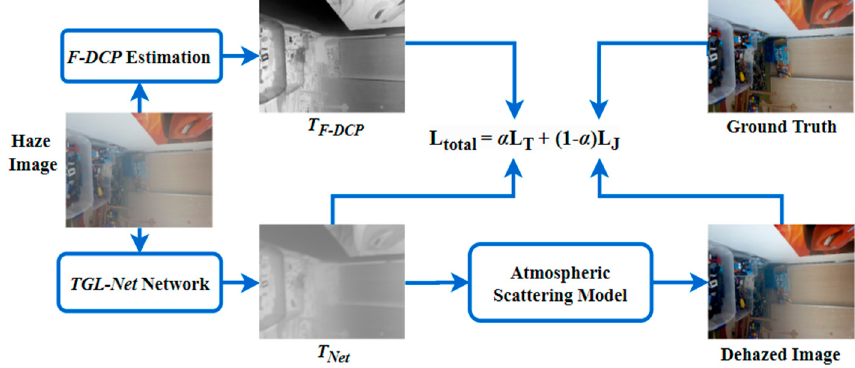
Figure 4. Training process for the proposed TGL-Net. L T and L J are defined in (2) and (4).